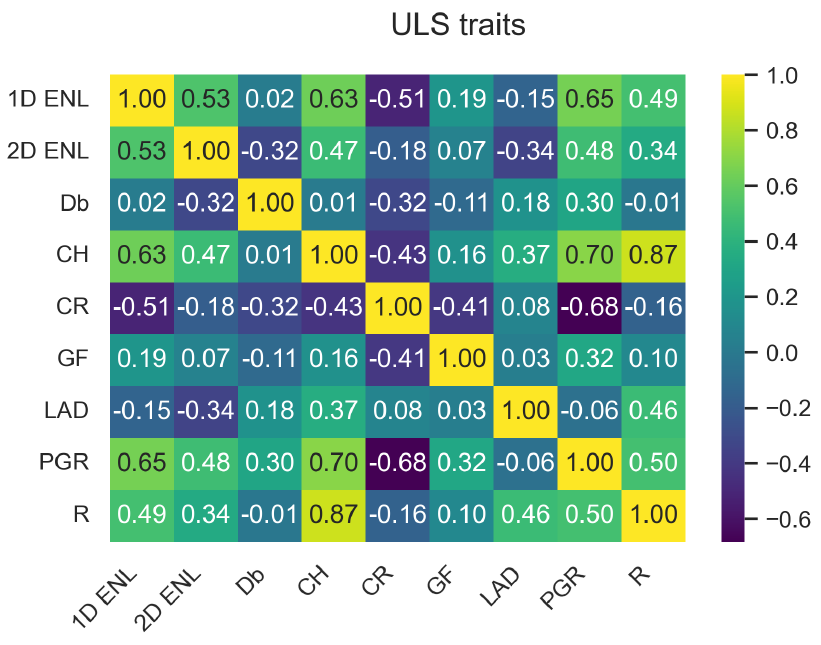
Figure A3. ULS correlation matrix at 0.5 m grid